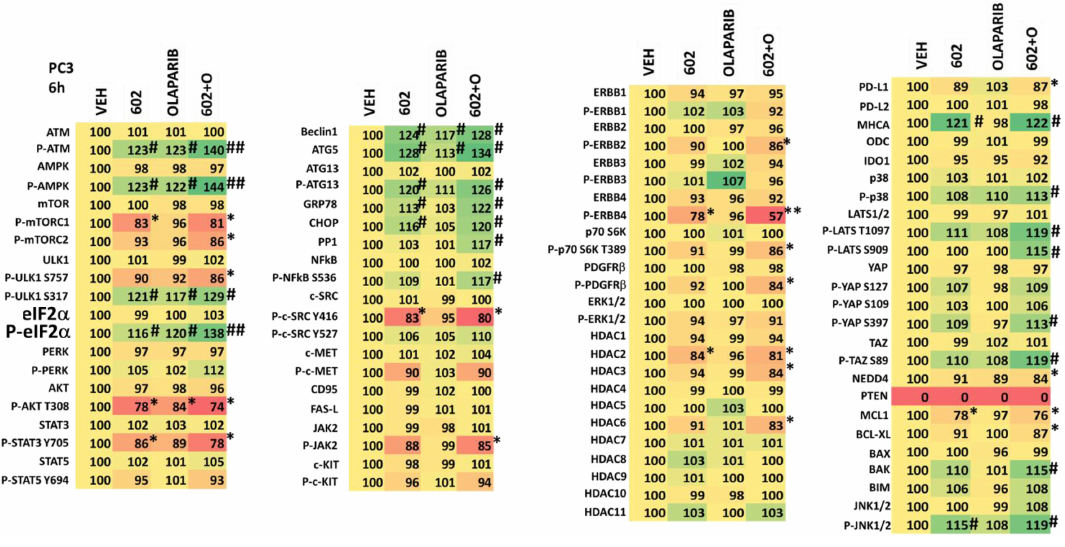
TABLE 3 Regulation of cell signaling by GZ17-6.02 and olaparib in PC3 prostate cancer